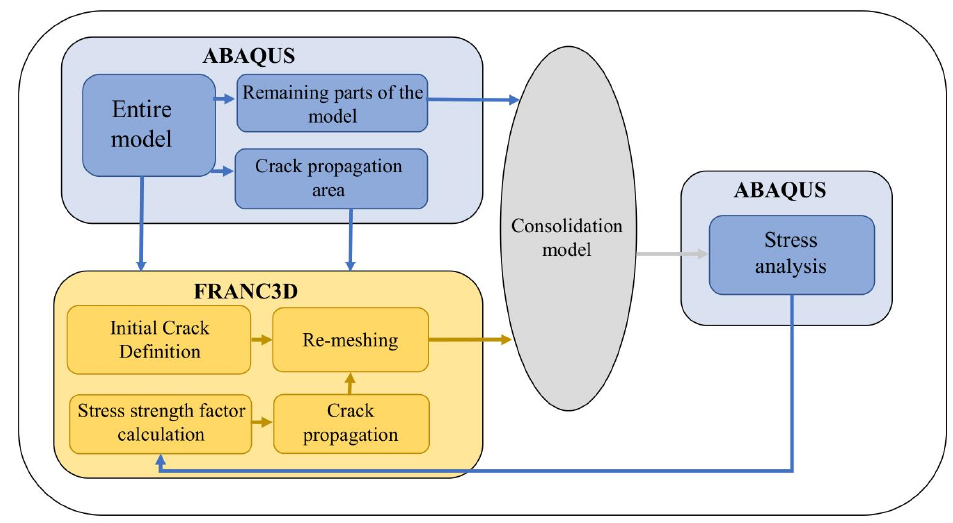
Figure 13. Relationship between P u,N /P u, 0 and a c /d .